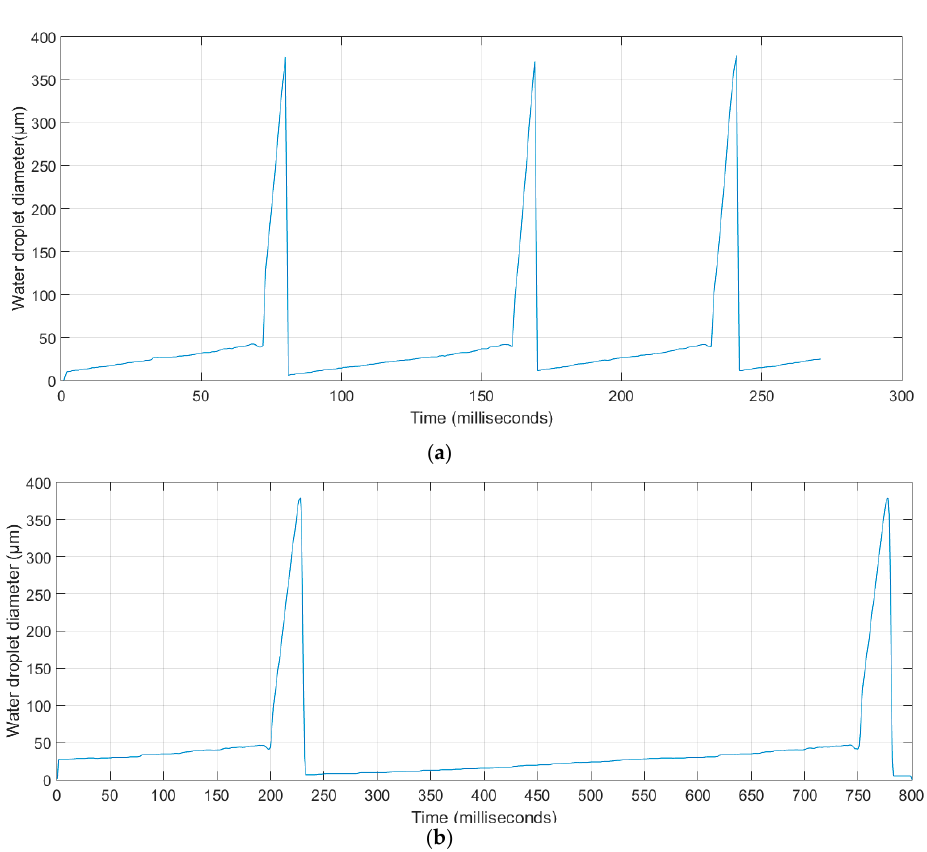
Figure 16. Dynamic evolution of droplet diameter: ( a ) flow parallel to gravity; ( b ) flow perpendicular to gravity.